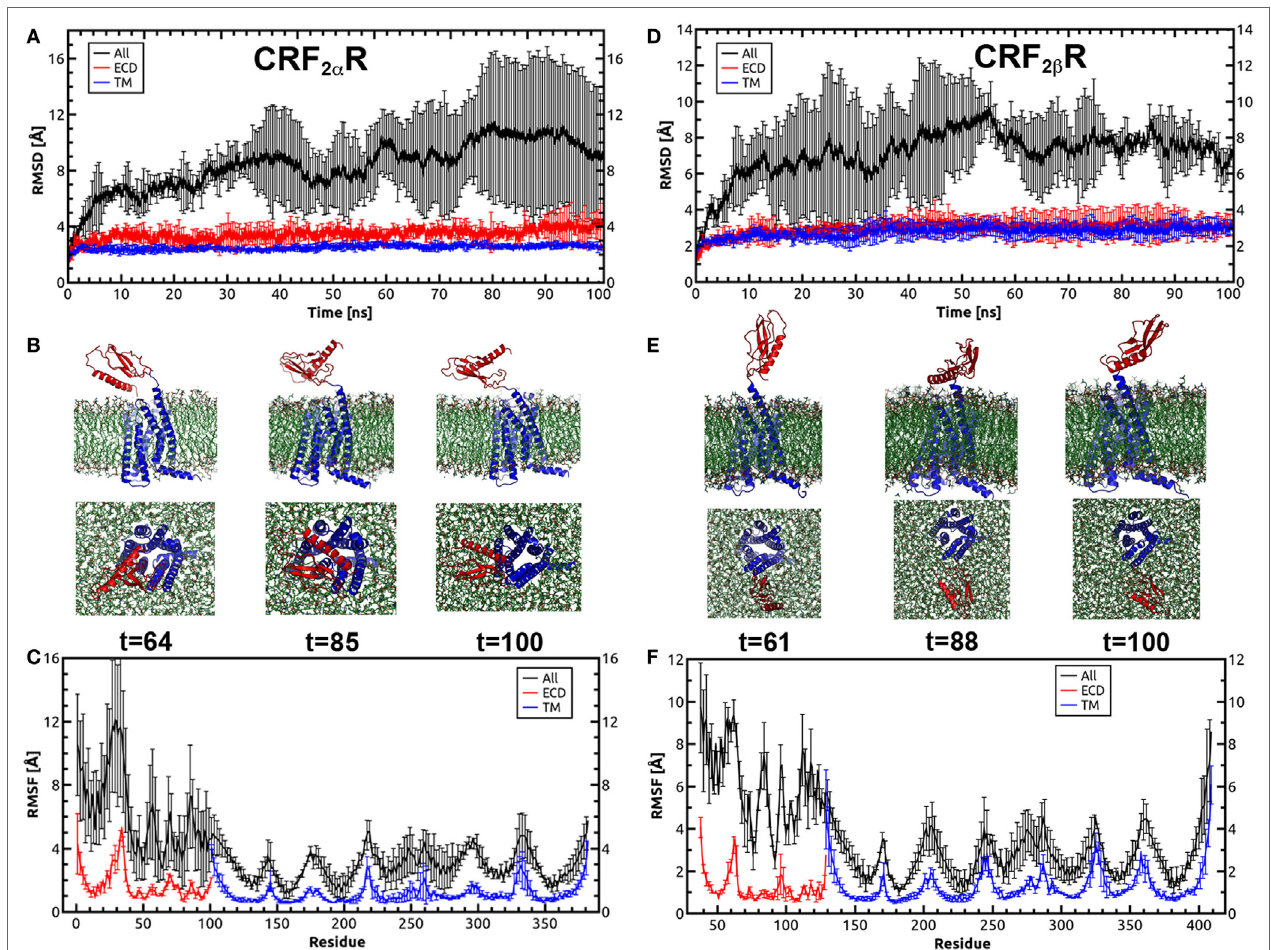
FigUre 5 | Molecular dynamics simulations for CRF 2 α R and CRF 2 β R. (a,D) Root-mean-square deviation (RMSD) values of the C α atoms of CRF 2 α R (a) and CRF 2 β R (D) over the time course of the simulation. (B,e) Conformational states of CRF 2 α R (B) and CRF 2 β R (e) in the MD simulation showing the orientation of the extracellular domain (ECD) with respect to the TM domain. Three snapshots taken from specific periods of the MD simulation are shown from side and bottom views. (c,F) RMS fluctuation (RMSF) values of the C α atoms of CRF 2 α R (c) and CRF 2 β R (F) residues. RMSD and RMSF values for the ECD (red lines), TM (blue lines), and full-length receptors (black lines) are